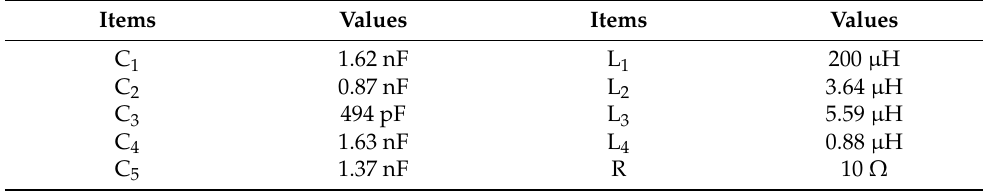
Table 2. The value of the circuit